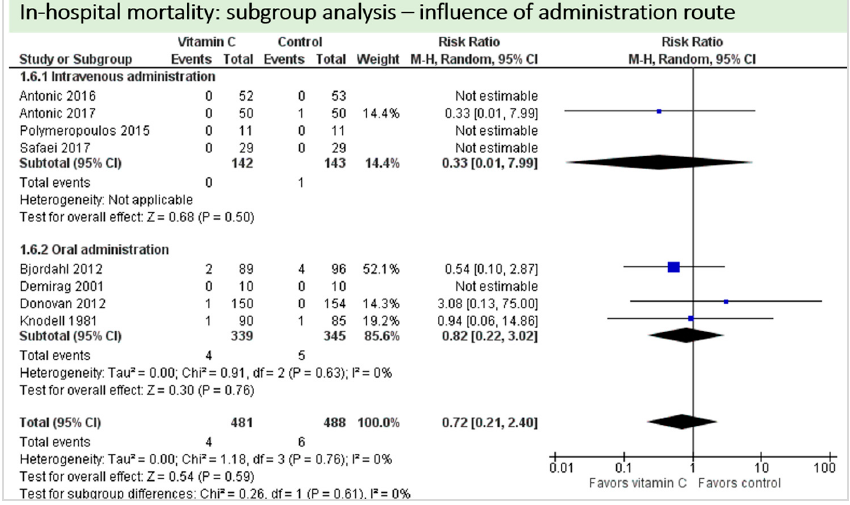
Figure 13. In-hospital mortality: subgroup analysis—Influence of administration route.